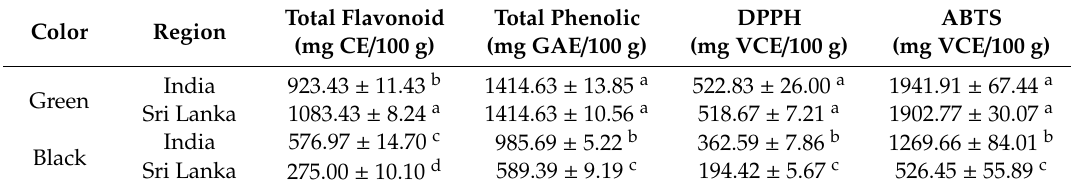
Table 2. Antioxidant compounds and radical scavenging e ff ect of green and black pepper.